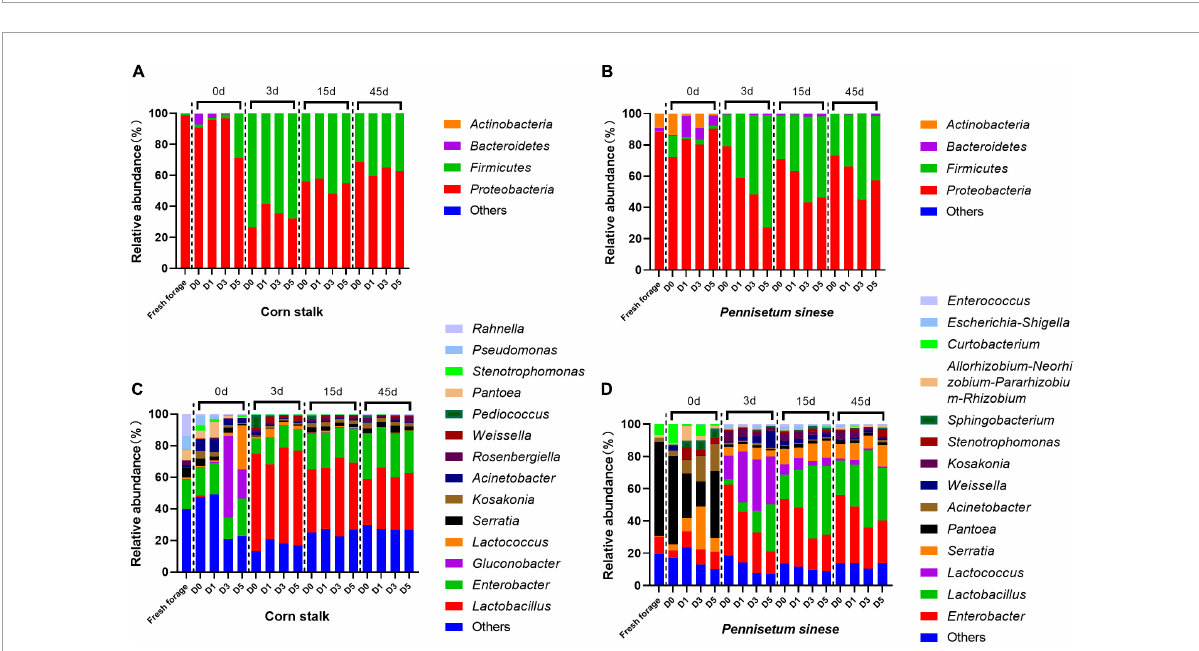
FIGURE2 Bacterial community structure and relative abundance, at the phylum [corn stalk, (A) ; Pennisetum sinese , (B) ] and genus [corn stalk, (C) ; P. sinese , (D) ] levels, of raw forage and silage. D0, undiluted; D1, 10 - 1 dilution; D3, 10 - 3 dilution; D5, 10 - 5 dilution.